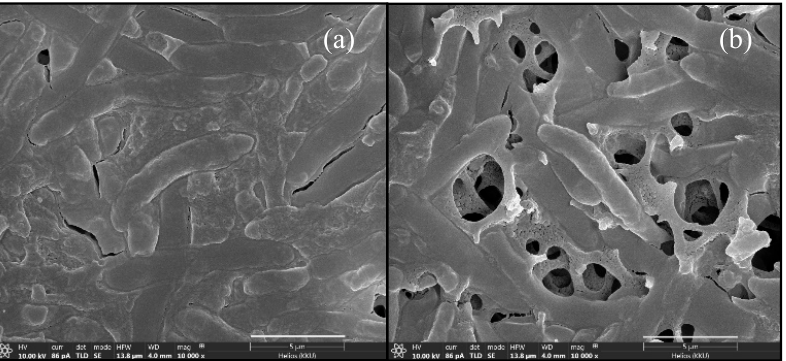
Figure 5. FE-SEM micrograph of C. beijerinckii TISTR 1461 at 48 h of ABE fermentation in SSJ medium by a single culture ( a ) and mixed cultures (inoculating C. beijerinckii after 6 h of Arthrobacter cultivation) ( b ). Magnification of 10,000 × . Scale bar: 5 µ